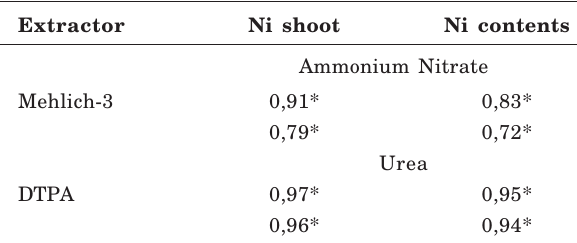
Table 5. Linear coefficients for the correlations between Ni contents and concentrations in the lettuce shoots and the concentrations recovered from the soil with DTPA and Mehlich-3